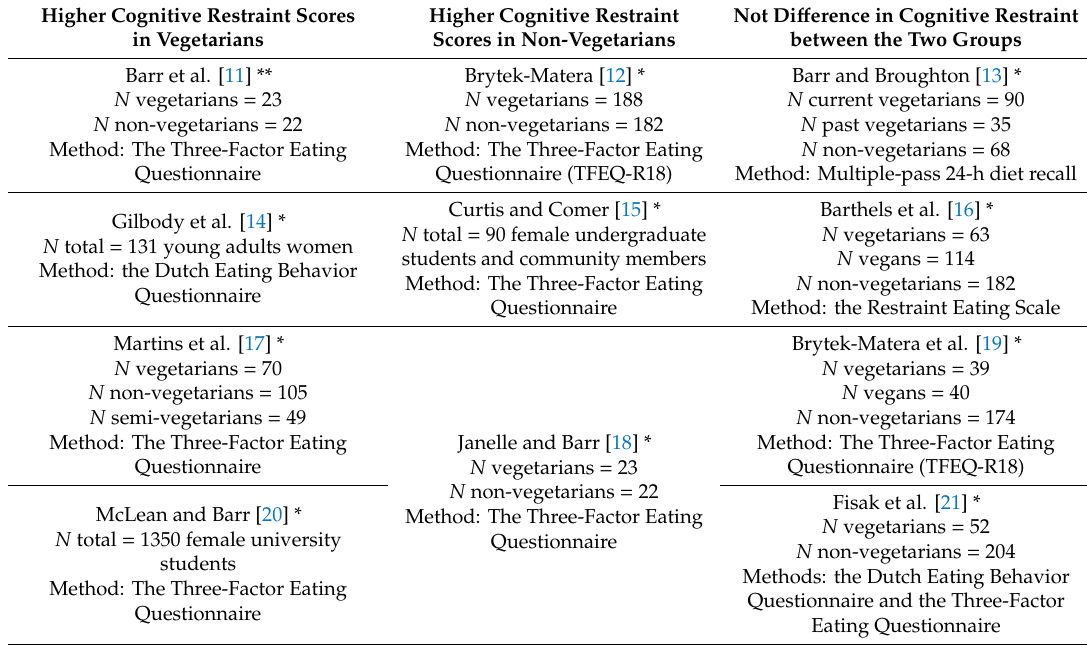
Table 1. Cognitive restraint scores between vegetarians and omnivores: the inconsistent results. Higher Cognitive Restraint Scores Higher Cognitive Restraint Not Di ff erence in Cognitive Restraint in Vegetarians Scores in Non-Vegetarians between the Two